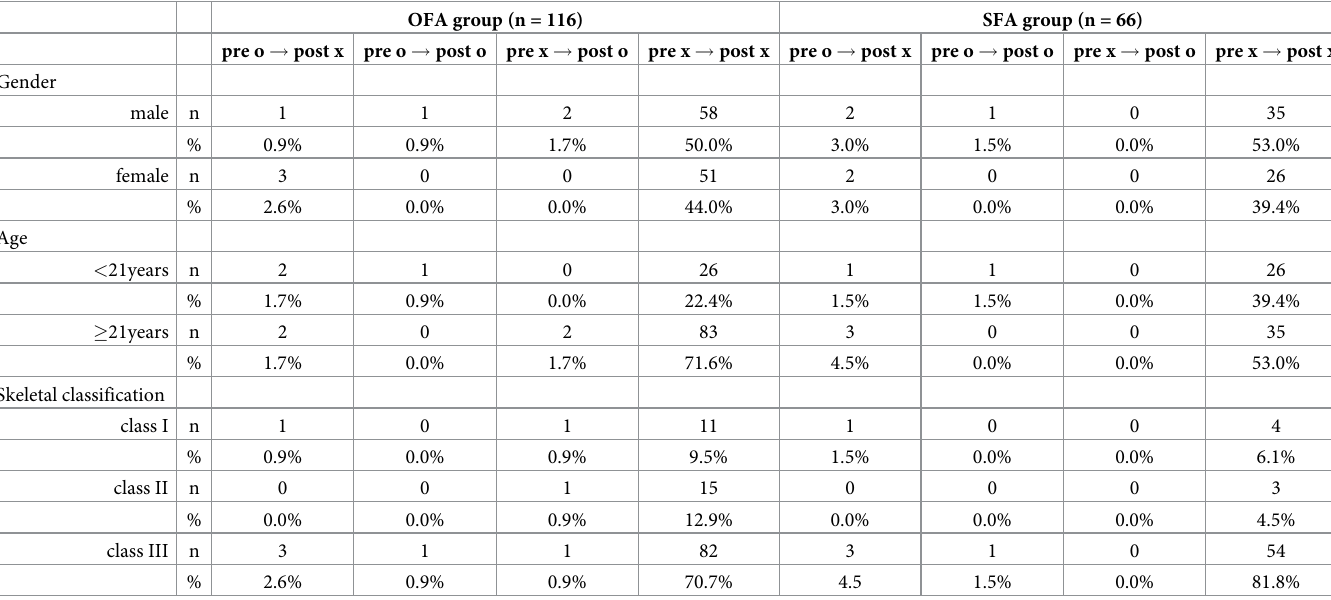
Table 6. Changes in TMJ pain disorders before the start of the surgical-orthodontic treatment and after surgery. OFA group (n = 116) SFA group (n =